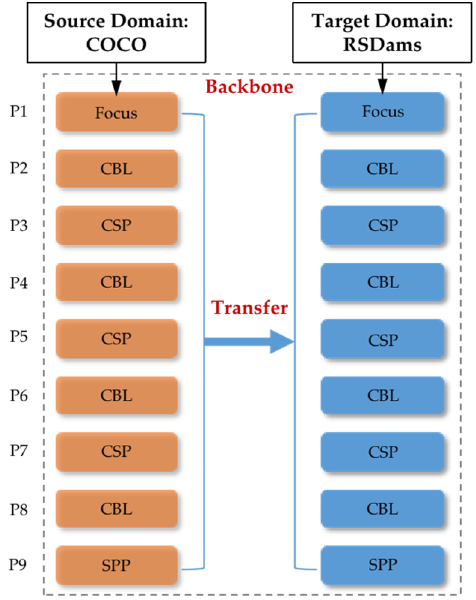
Figure 5. Sketch map of the transferred 1–9 layers of YOLOv5s-ViT-BiFPN in this study. Source domain indicates the COCO dataset trained on the YOLOv5s network, of which the first nine layers were the same as those of YOLOv5s-ViT-BiFPN. The target domain was the RSDams dataset.